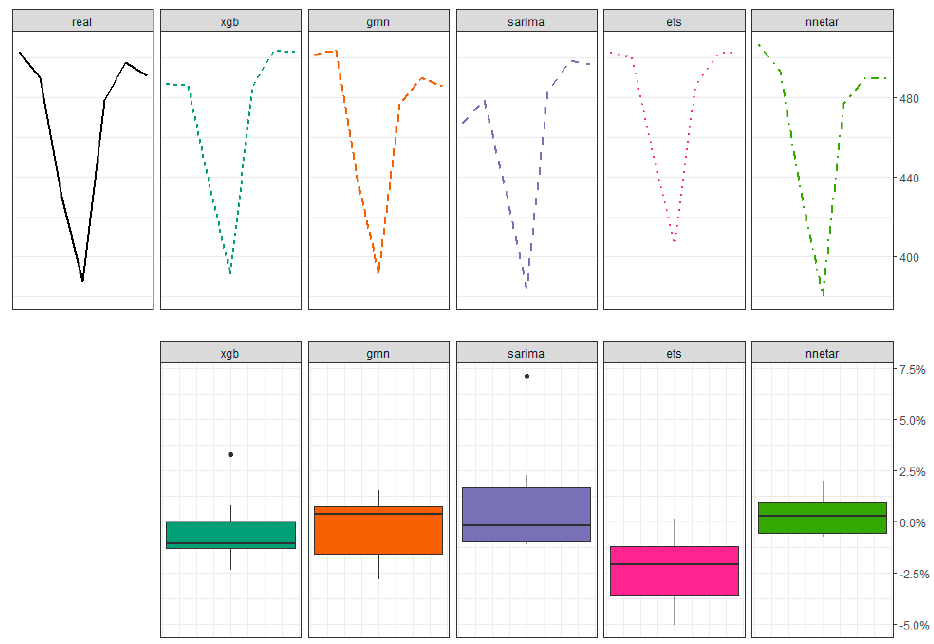
Figure 13. Weekly forecast (description as above).